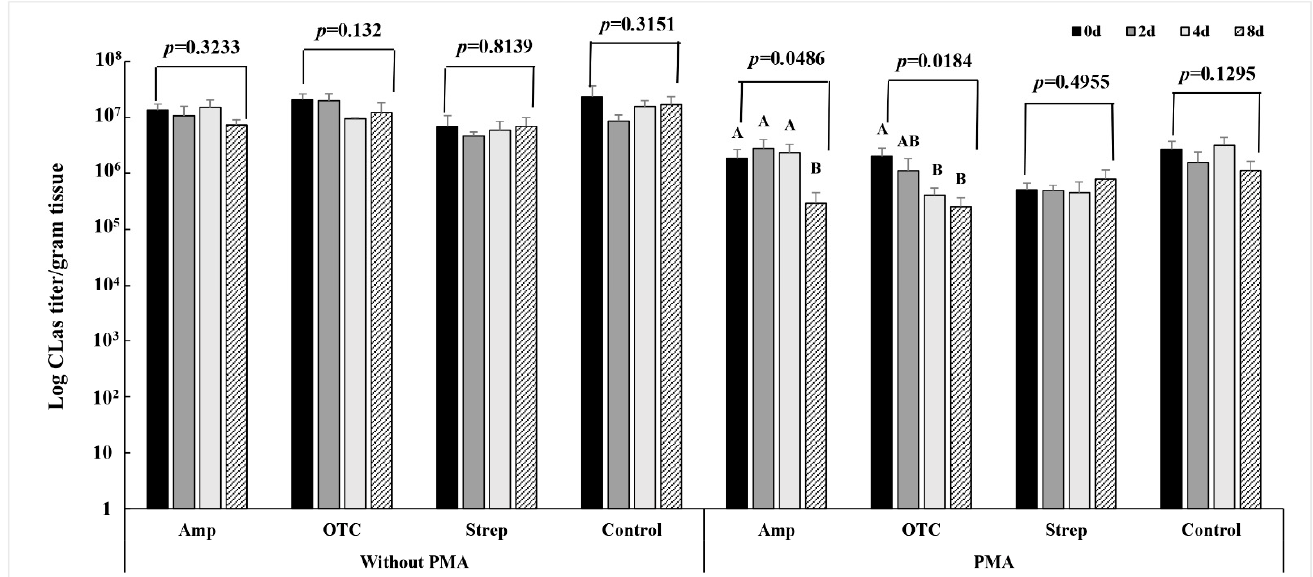
Figure 5. Assessing antibacterial activity of chemical compounds (Amp, OTC, Strep, and water control) against CLas via PMA ‐ qPCR in ‐ field test. Results of experimental treatments denoted with the same upper ‐ case letter were not significantly different according to Duncan’s multiple range test at p ≤ 0.05. Standard error of the mean is indicated by a vertical line.